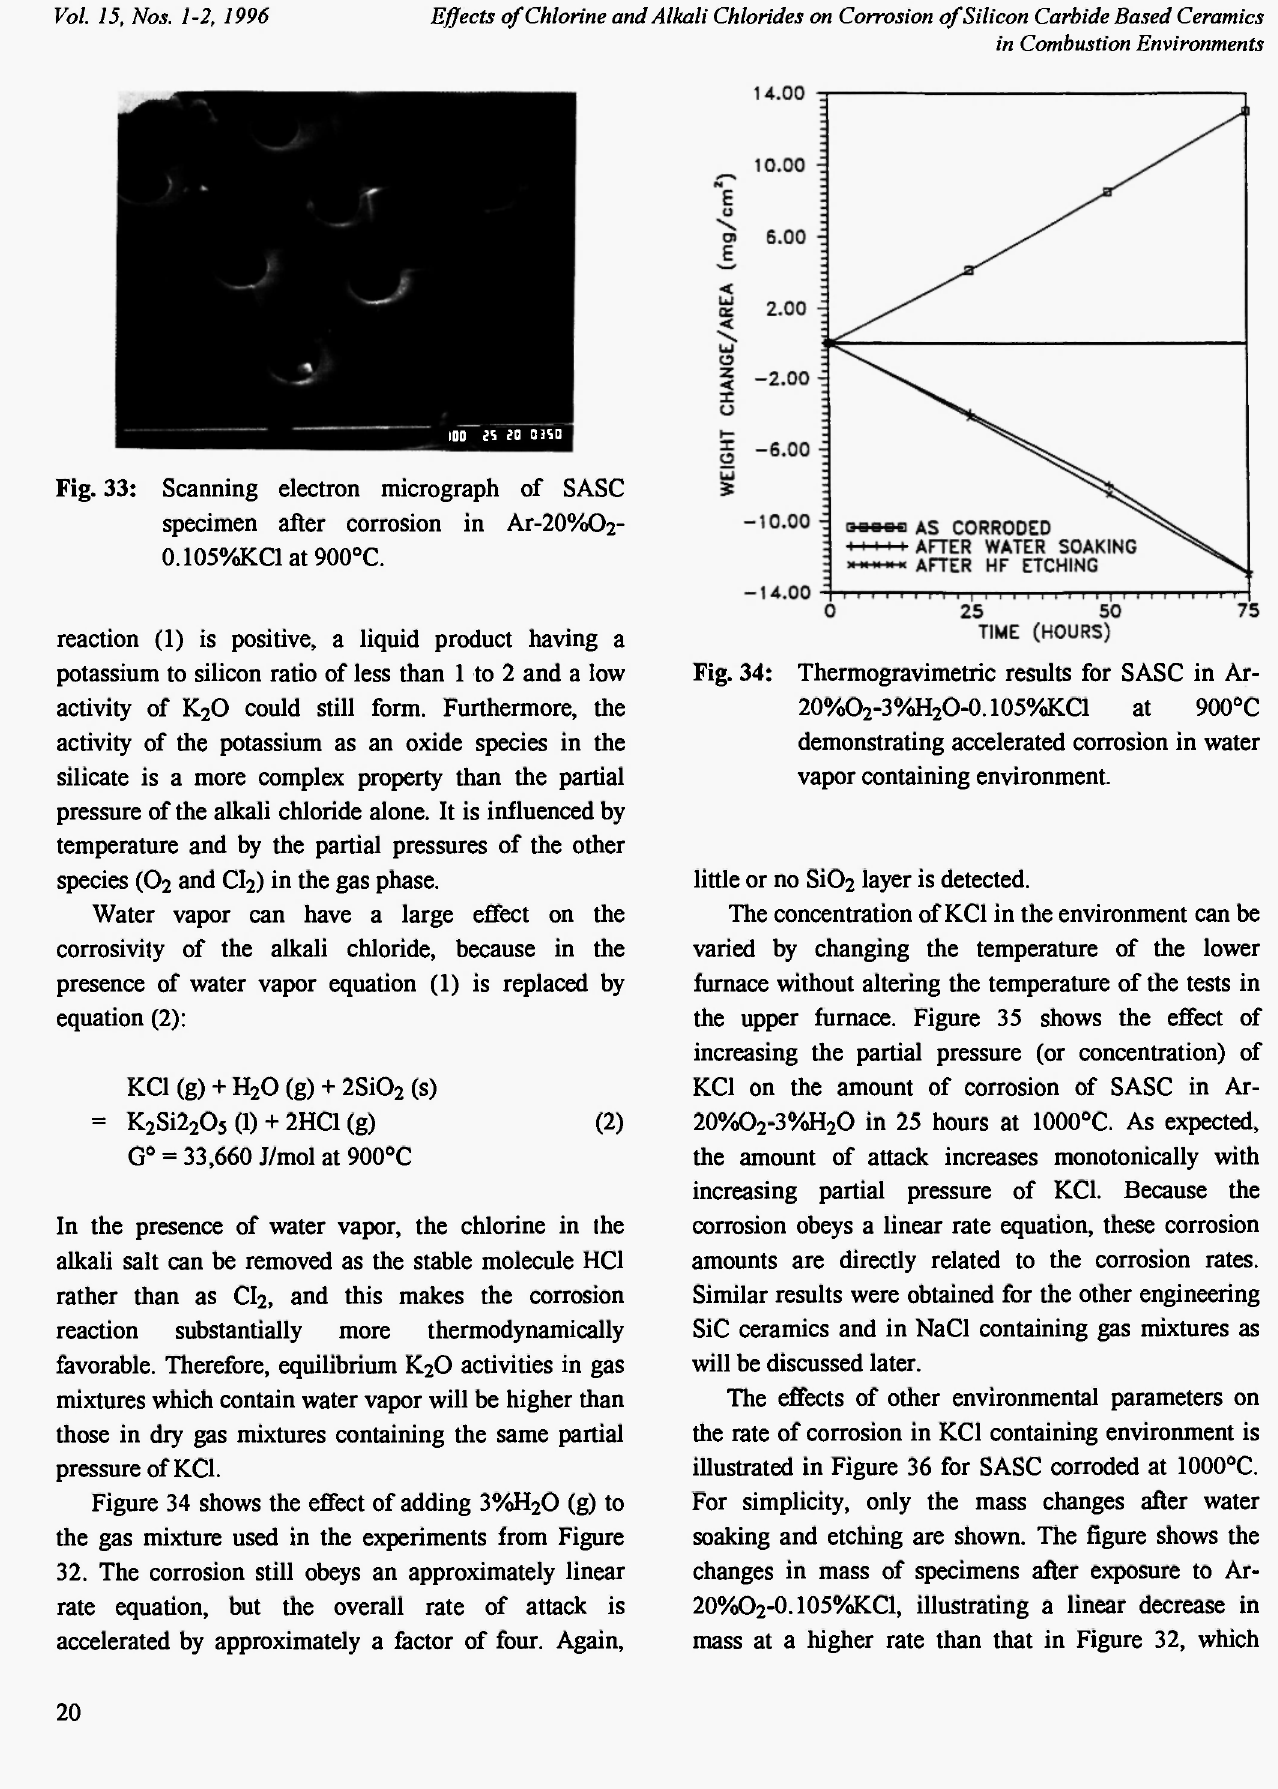
Fig. 34: Thermogravimetric results for SASC in Ar- 20%02-3%H 0-0.105%KC1 at 2